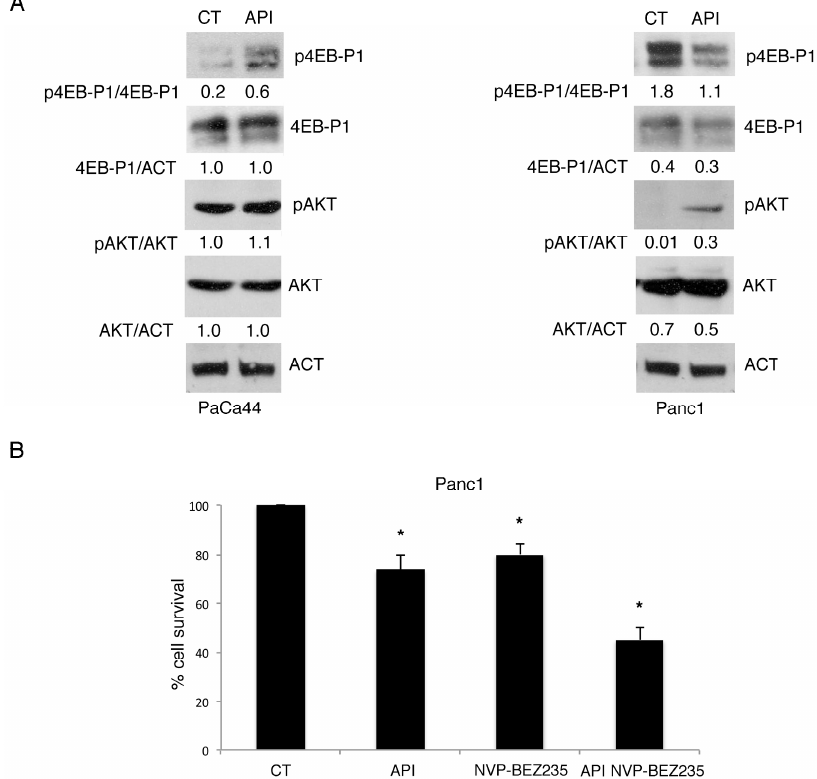
Figure 7. HSP90 expression is regulated by mTORC1 activation. ( A ) p4EBP1, EBP1, pAKT, and AKT expression in Apigenin-treated or untreated PaCa44 and Panc1 cells was evaluated by western blot analysis. Actin was used as loading control. A representative experiment out of three is shown and the densitometric analysis of the ratio of p53 / actin is reported; ( B ) Viability of untreated or 12.5 µ M Apigenin-, 100 nM dual PI3K / mTOR inhibitor NVP-BEZ235-treated, and the combination of 100 nM NVP-BEZ235 and 12.5 µ M Apigenin in Panc1 cells was evaluated by trypan blue exclusion assay. Mean plus SD of three independent experiments is reported. * p -value < 0.05. Control (CT); Apigenin (API); eukaryotic translation initiation factor 4E (eIF4E)-binding protein 1 (4EB-P1); phospho-eukaryotic translation initiation factor 4E (eIF4E)-binding protein 1 (p4EB-P1); protein kinase B (AKT); phospho-protein kinase B (pAKT); actin